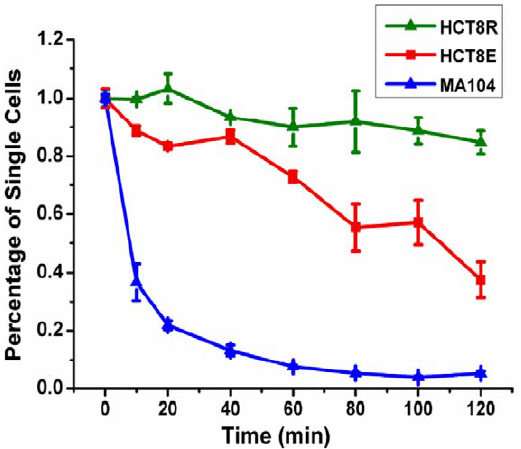
Figure 2. The coulter counter assay is used to measure specific homotypic cell-cell adhesion rates for HCT-8 E and R cells. (a) Comparison of cell-cell adhesion rates of original HCT-8 E cells (never exposed to 21 kPa PA gels), disassociated HCT-8 R cells harvested from 21 kPa PA gels, and normal non-cancerous epithelial Ma104 cells. HCT8 R cells have the lowest cell-cell adhesion. Each data point consists of 3 duplicates, and each duplicate consists of 5 6 10 5 cells of respective cell